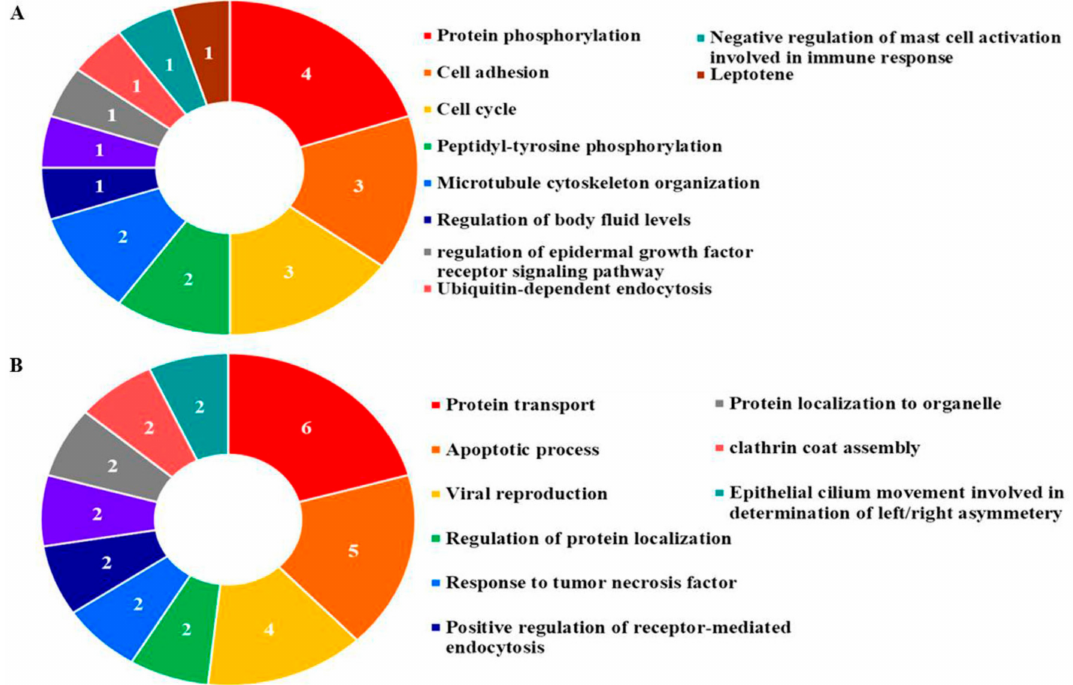
Figure 10. Gene ontology analysis of ( A ) AGS and ( B ) MKN28 cells. The pie charts representing the distribution of the identified proteins according to their biological process. Gene ontology analyses of the determined proteins were assigned according to their biological function, using the web-based tool at GeneCodis